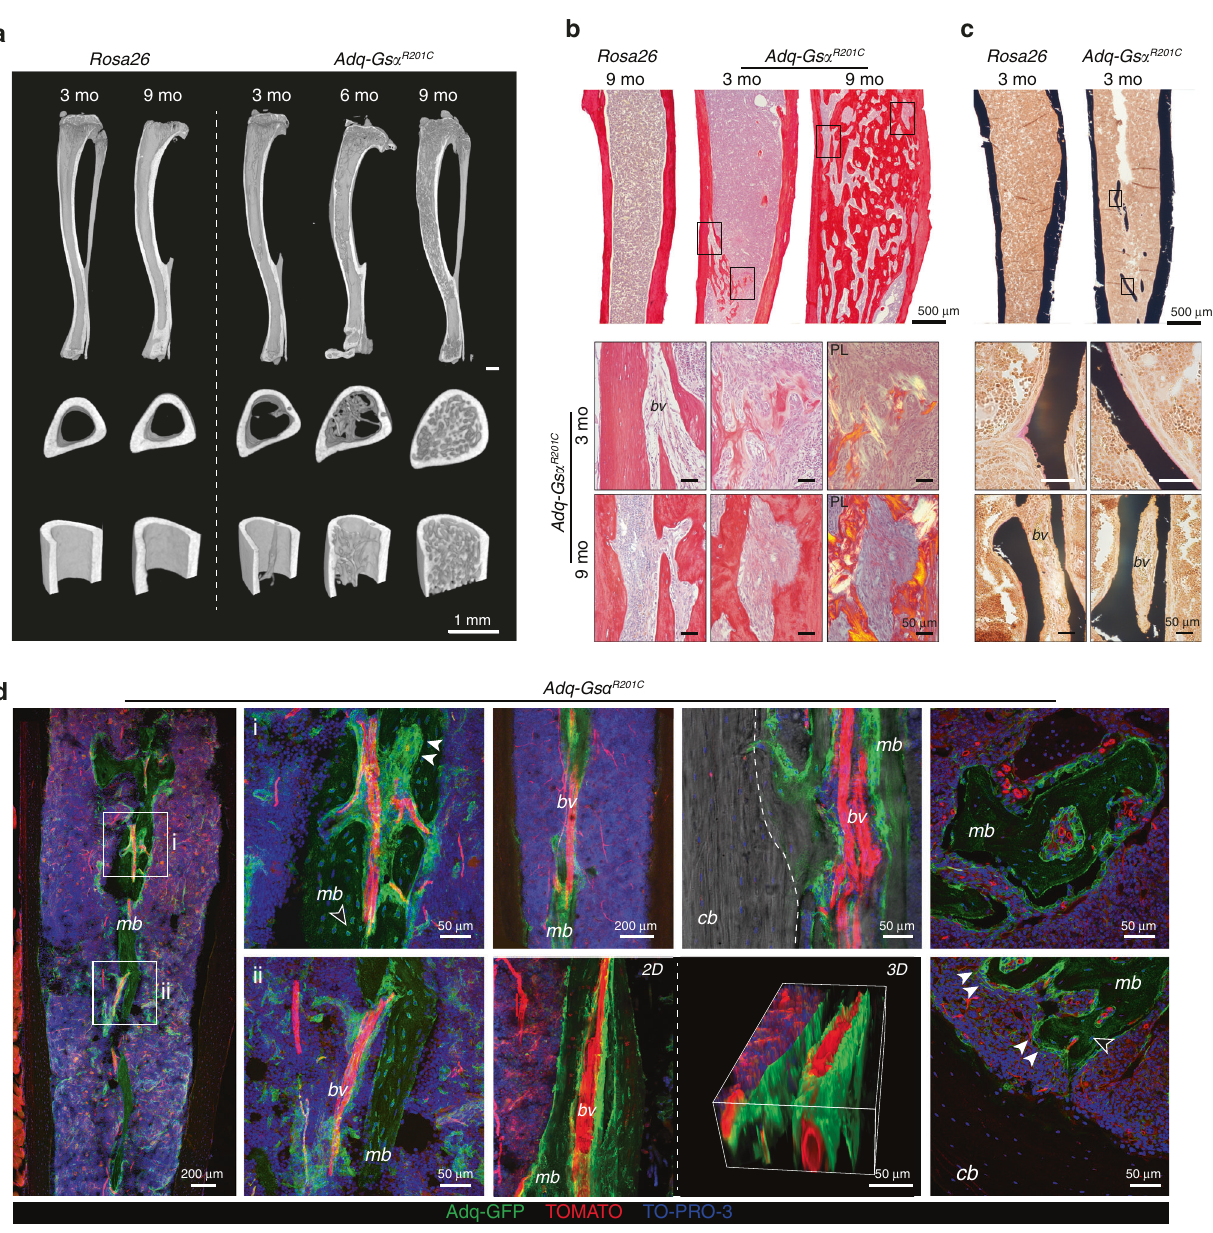
Fig. 5 Diaphyseal intramedullary bone formation in female Adq-Gs α R201C mice. a Representative micro-computed tomography images of mice at different ages, showing the appearance and progression of the diaphyseal intramedullary bone. Transverse images were taken 2 mm above the tibia- fi bular junction. b Transmitted and polarized (PL) light microscopy views of Sirius red stained sections of the tibial midshafts showing the appearance of the intramedullary bone in Adq-Gs α R201C mice at 3 months of age and its subsequent expansion with obliteration of the medullary canal at older ages. PL shows the mixed woven and lamellar bone structure. c Von Kossa/Van Gieson stained MMA sections of undecalci fi ed tibial midshafts showing mineralized intramedullary bone with a thin layer of osteoid rimmed with osteoblasts. d Representative images from confocal microscopy, showing medullary bone ( mb ) distributed around marrow blood vessels ( bv ) and its focal connection with cortical bone ( cb, dotted line ). GFP expression was observed in osteoblasts ( arrowhead ) and osteocytes ( hollow arrowhead ). 3D reconstruction was performed on a 50 μ m-thick section using ImageJ and osteoblast parameters ( Fig S6b) were signi fi cantly higher in cavity (Fig. 6b – d) similarly to what was observed in untreated Adq-Gs α R201C mice upon E2 treatment compared with Veh-treated female mice bearing the same genotype (Fig. 5). The origin of the intramedullary bone was explored in the tibiae and femora Adq-Gs α R201C and E2-treated control mice, in the absence of of E2-treated Adq-mTmG ; Gs α R201C male reporter mice, in which it signi fi cant changes in osteoclast parameters (Fig S6c). included only GFP positive osteoblasts and osteocytes (Fig. 6e – g). After E2 treatment, an increase in the radiodensity of the Osteogenic Adq-cells are not found in all skeletal segments metaphysis of long bones was detected in all male mice As observed in control Adq-mTmG mice, the expression of GFP in independent of their genotype (Fig. 6b, c). Histomorphometric trabecular osteoblasts and osteocytes was never detected in analyses of trabecular bone demonstrated that BV/TV (Fig S6a) the tail vertebrae of Adq - mTmG ; Gs α R201C mice (Fig. S1e, Fig. 7a).